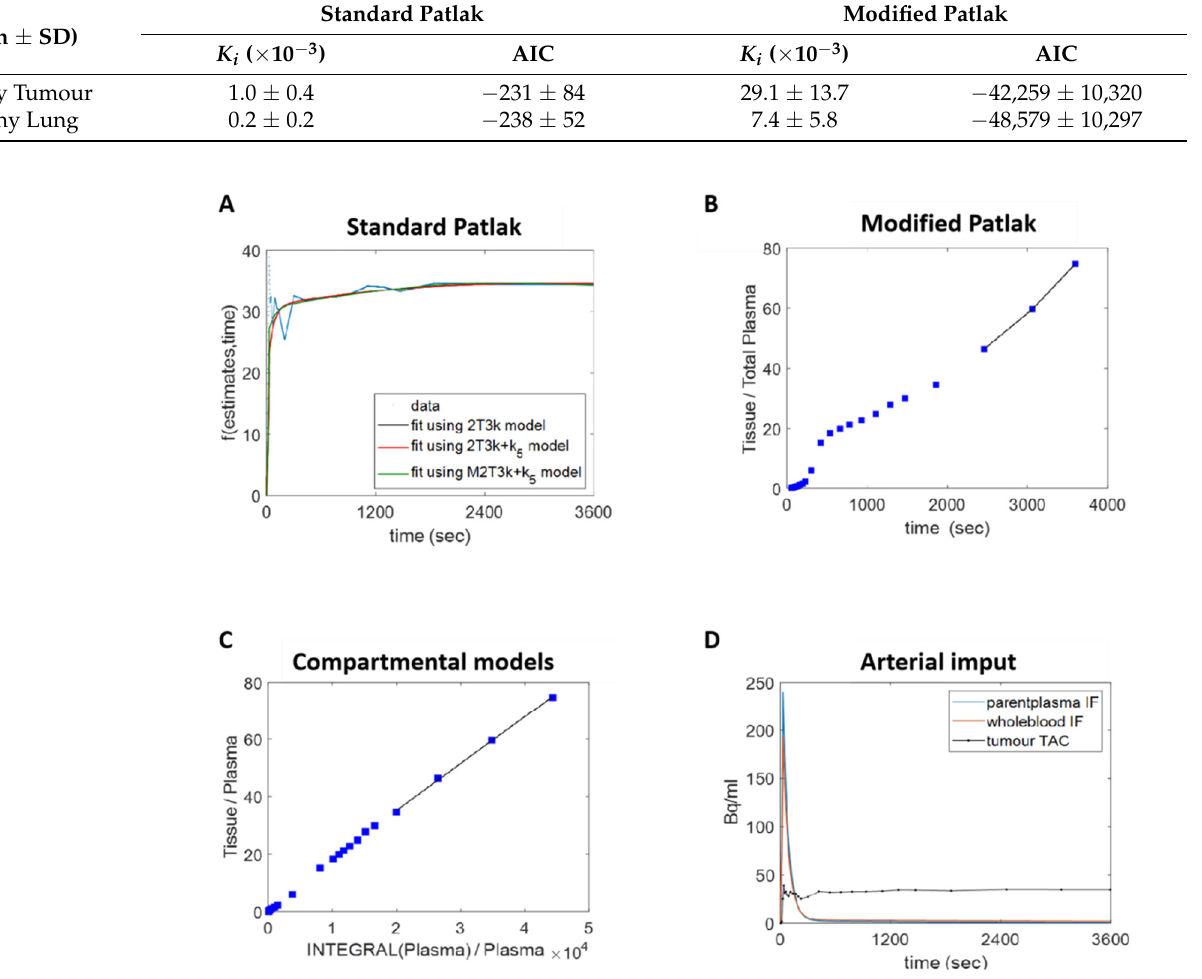
Table 2. The results of the compartmental analysis.